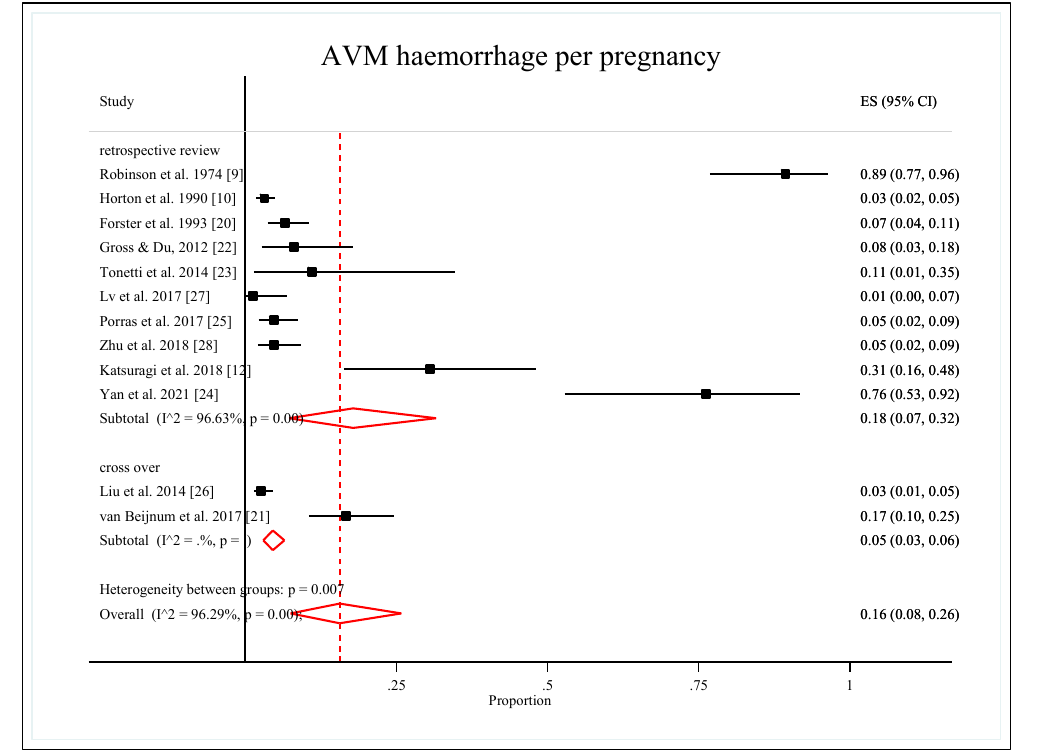
Figure 4. Forest plot of the pooled proportion of AVM hemorrhage per pregnancy by study design [9,10,12,20–28].